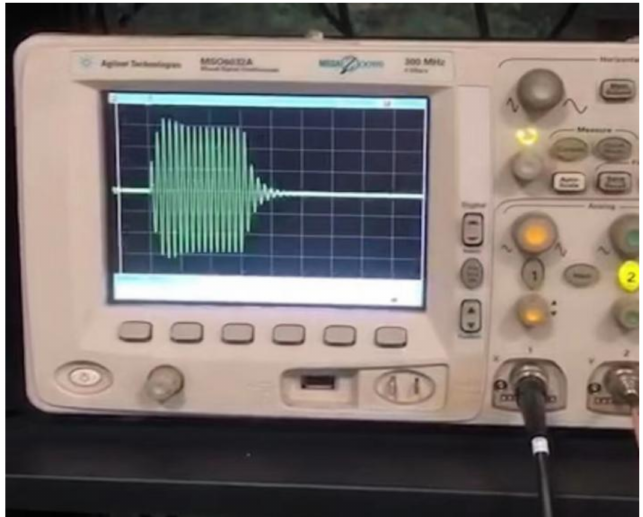
Figure 15. A waveform that the hydrophone received when the transducer transmitted a sound wave. Table 3. Actual test environment of the transducer.